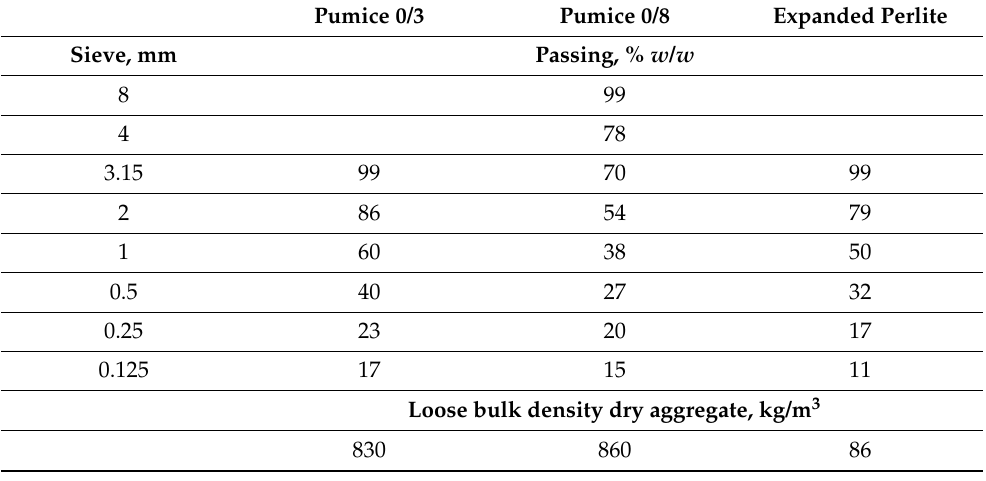
Table 1. Particle size distribution and loose bulk density of lightweight aggregates.